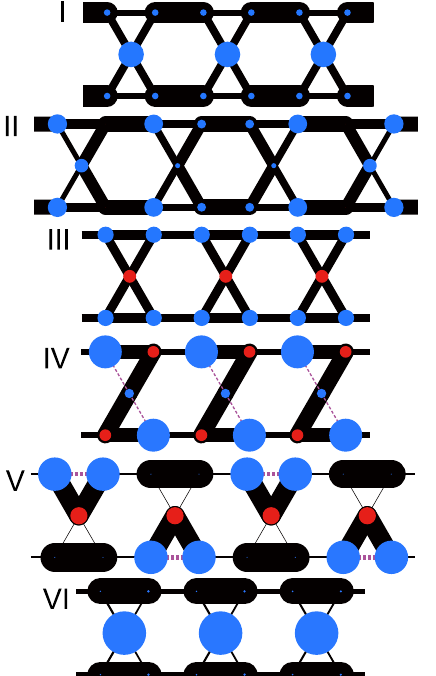
Fig. 3 Magnetic structures of each phase. The nearest-neighbor spin-spin correlation h S i (cid:2) S j i (cid:3) h S z i ih S z j i and the local magnetization h S z i i around the center of the chain with N = 200 under the open boundary condition for the six phases, where S i is the spin- 1 operator, S z i is the z component of S i , and 2 N is the number of sites. Black solid (purple dashed) lines connecting two nearest-neighbor sites denote negative (positive) values of the spin – spin correlation, and their thickness represents the magnitude of the correlation. The blue (red) circles on each site denote the positive (negative) value of Fig. 5 Entanglement entropy of the kagome strip chain. The cluster used h S z i i , and their diameter represents its magnitude. Roman numerals denote in the calculations is the open boundary condition for L = 200( N = 5× 200), the 1/5 plateau phases and correspond to those in Fig. 2. In VI, the value of where L is the number of fi ve-site units in the kagome strip chain. The h S z i i at the center is 0.4193, and that of h S i (cid:2) S j i (cid:3) h S z i ih S z j i of the thickest results of the calculation of the entanglement entropy with respect to line is − 0.6513. ln ½ L = π sin ð π j = L Þ(cid:4) at J 1 = 1.0 and J 2 = 0.7 (Phase II), and J 1 = 0.9 and J 2 = 0.3 (Phase III), are represented by black squares and red circles, respectively, where j denotes the position of the 5-site unit. Here, J 1 and J 2 are the exchange interactions shown in Fig. 1. The value of the central charge c was obtained by fi tting the entanglement entropy data using straight lines. The fi tting lines are shown as dashed